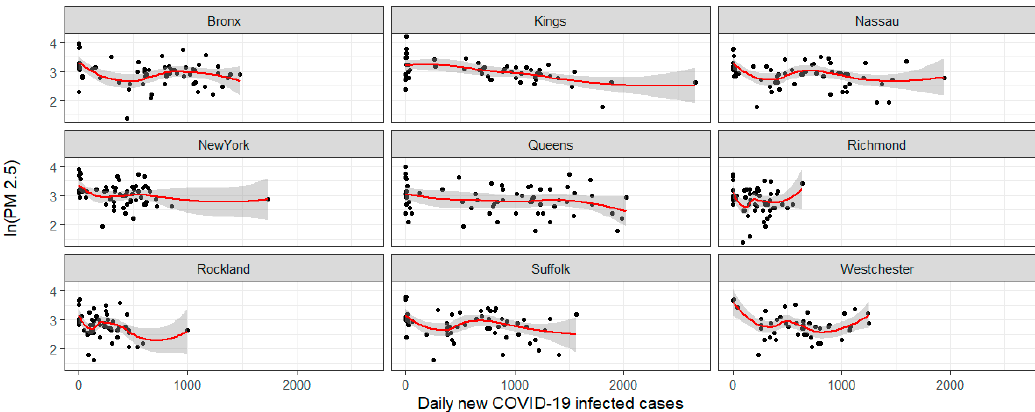
Figure A4. Scatter plots for the number of daily COVID-19 new cases vs. PM 2.5 (in µ g / m 3 ) represented Figure A4 . Scatter plots for the number of daily COVID-19 new cases vs. PM 2.5 (in μ g/m 3 ) represented